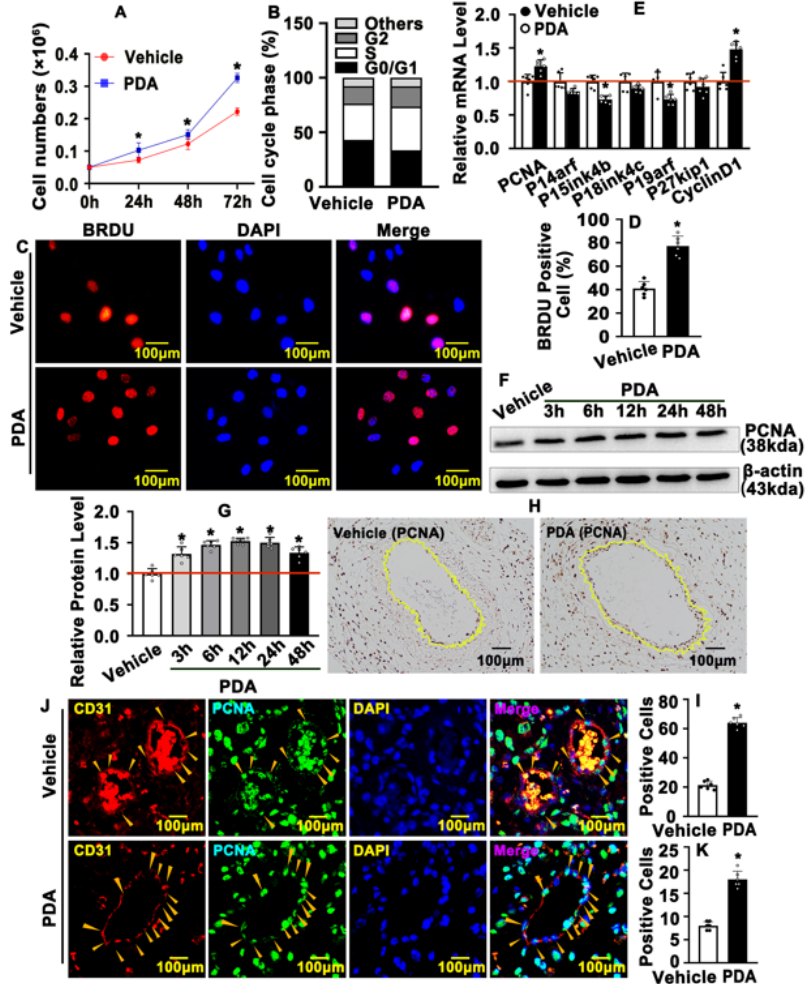
Figure 2. PDA promotes vascular endothelial cell proliferation. ( A ) HUVECs were treated with PDA (10 µ M), the cell numbers were counted at different time points (24 h, 48 h, 72 h) ( n = 6). ( B ) HUVEC-Cs were treated with PDA (10 µ M, 24 h) and the cell cycle was determined using flow cytometer analysis after propidium iodide (PI) staining. ( C ) HUVEC-Cs were treated with BRDU-labeling buffer for 20 h following PDA (10 µ M) treatment for 24 h. IF staining was performed to determine BRDU-incorporated HUVEC-Cs. ( D ) The BRDU-positive cells were quantitatively evaluated ( n = 6). ( E ) HUVEC-Cs were treated with PDA (10 µ M, 24 h), and the mRNA levels of proliferation-related genes were detected using real-time PCR ( n = 6). ( F ) Western blotting was used to detect the expression of PCNA in HUVEC-Cs at different time points after PDA (10 µ M) treatment. The quantitative data are shown in ( G ) ( n = 8). ( H ) IHC staining was performed against the proliferation marker gene PCNA on the left carotid artery partial ligation model following PDA treatment for 7 days. PCNA-positive cells in neointimal areas are shown in ( I ) ( n = 8). ( J ) IF staining was used to evaluate the expression of PCNA in blood vessels within the anterior tibial muscle of mice that were intramuscularly injected with cardiotoxin and treated with PDA (20 mg/kg) for 5 consecutive days. Yellow arrows indicate regions containing CD31–positive and PCNA-positive vascular endothelial cells. PCNA-positive cells in neointimal areas are shown in ( K ) ( n = 8). Analytical data are expressed as means ± SEM, * p < 0.05.